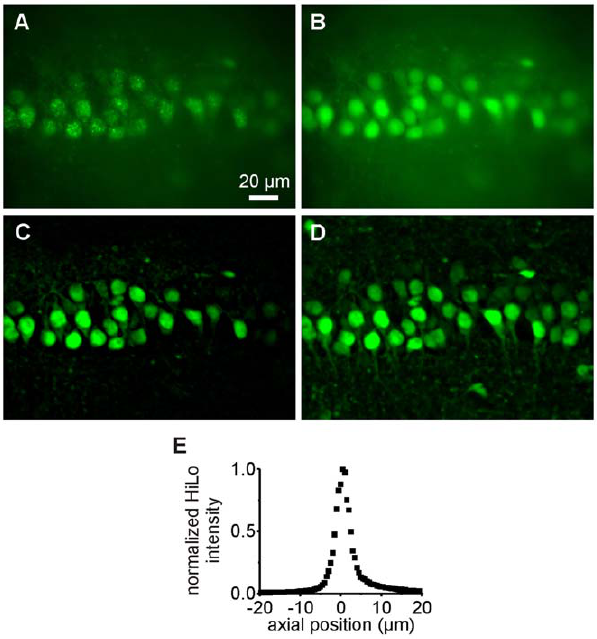
Figure 2. Optical sectioning with HiLo microscopy. A–C. Speckle (A) and uniform (B) illumination images used in the calculation of the quasi-confocal HiLo image (C). D. z-projection of 12 HiLo sections (including C) separated by D z=2 m m. E. Measurement of the HiLo microscope axial resolution: integrated signal from a thin fluorescent layer ( < 0.3 m m) as a function of defocus z. The measured axial resolution is 4 m m FWHM.